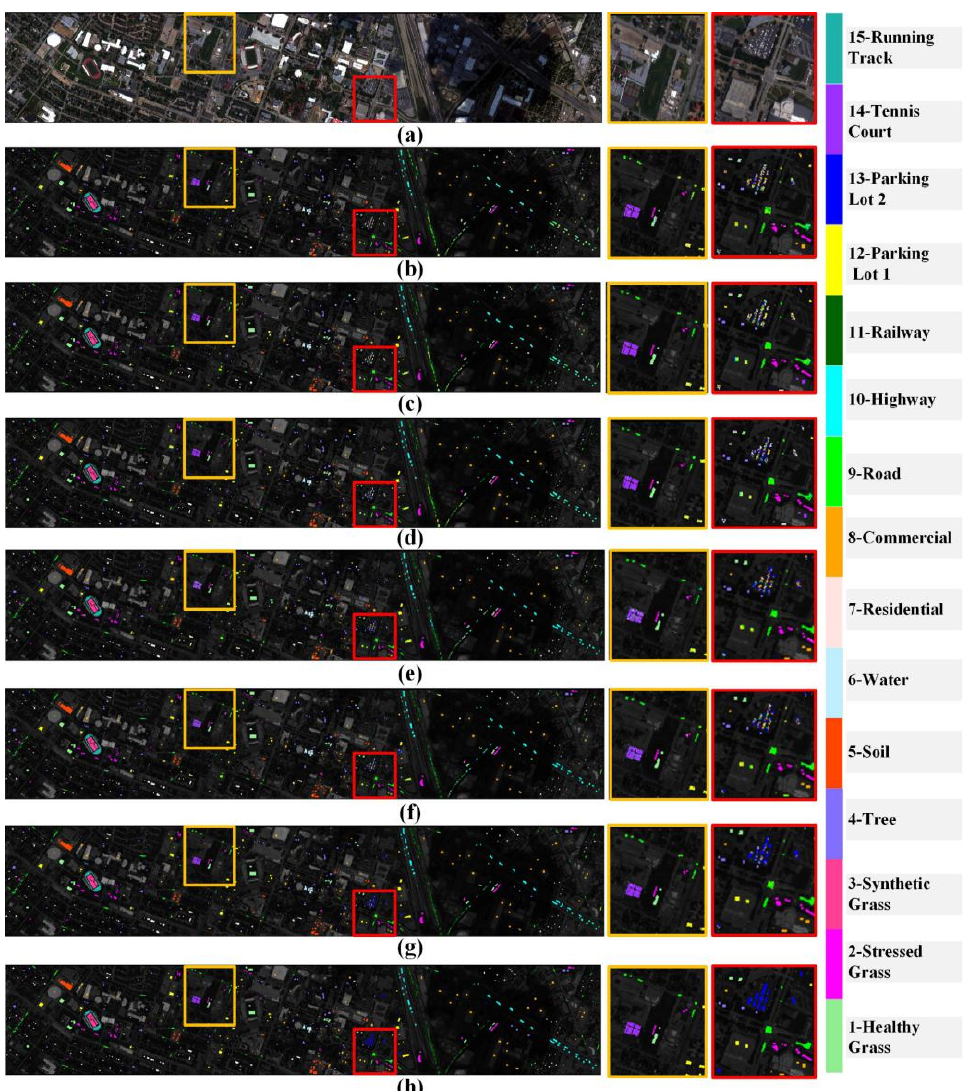
Figure 12. Classification map generated by Houston 2013 dataset with approaches in comparison: ( a ) pseudo-color image; ( b ) FDDL; ( c ) DPL; ( d ) ResNet; ( e ) RNN; ( f ) CNN; ( g ) ours; ( h ) ground truth. The rectangles with the colors of red and yellow represent the parking lot space and building